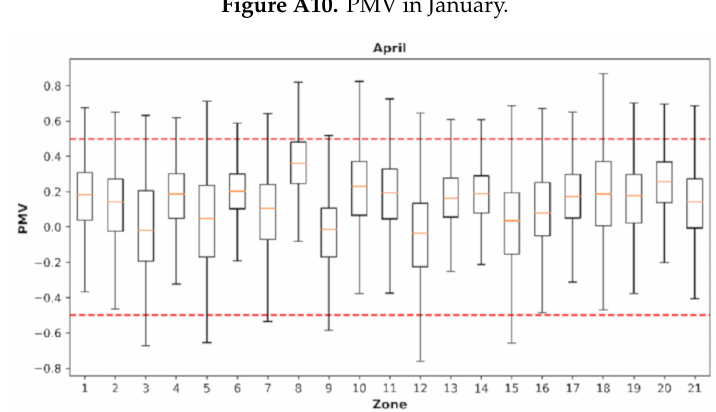
Figure A11. PMV in April.